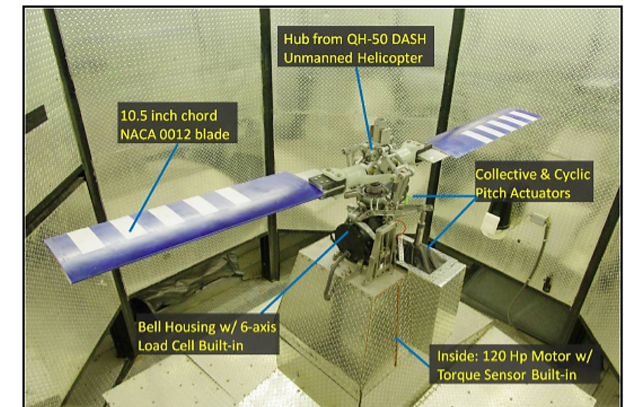
Figure 4. Photograph of AERTS test stand.